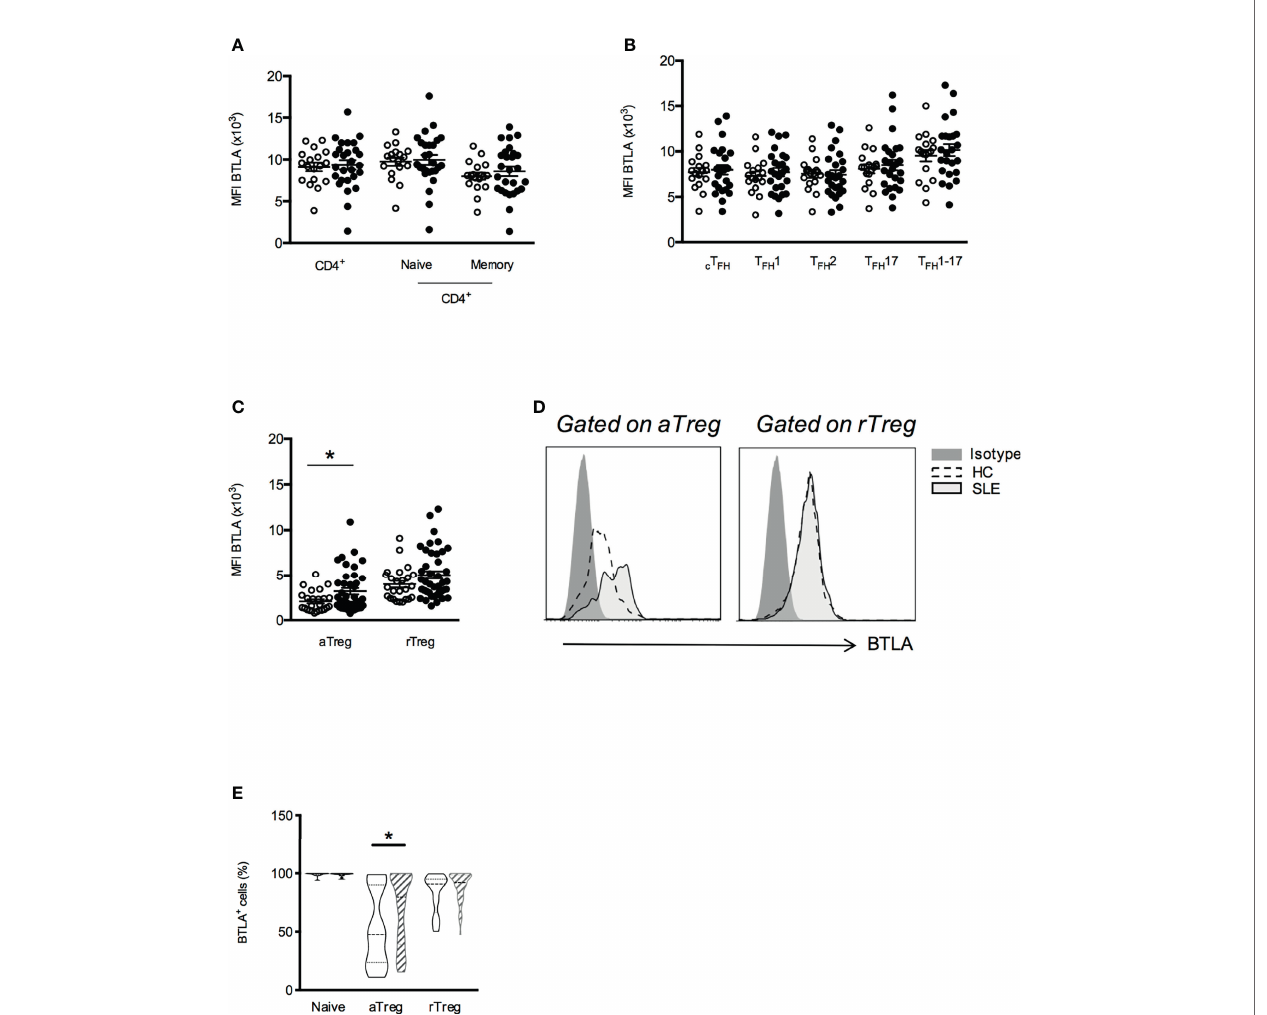
FIGURE 2 | BTLA expression is enhanced on aTregs from SLE patients compared to HC. Comparison of BTLA expression (MFI) on CD4 + T cell (A) , cT FH (B) and Treg subsets (C) in HC (white dots, n=17-34) and SLE patients (black dots, n=25-47). (D) Representative histograms of BTLA staining in aTregs and rTregs from one HC and one lupus patient. (E) Comparison of BTLA expressing cell subset frequencies between HC (empty boxes) and lupus patients (hatched boxes). Frequency values are displayed as mean (dashed lines) plus lower and upper quartiles (dotted lines). Results are expressed as mean ± SEM and each dot represents one individual. *p < 0.05,